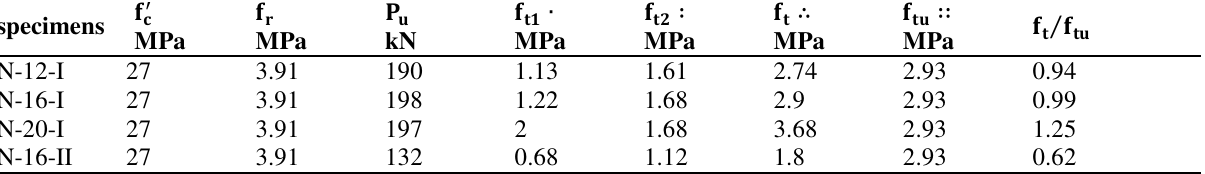
The Results of the Mechanical Properties for the Experimental Models